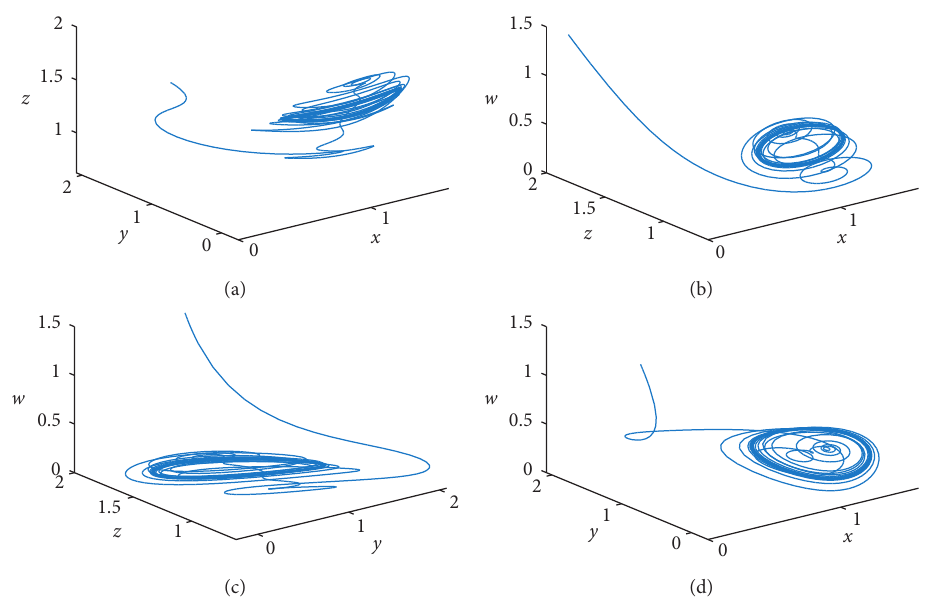
Figure 1: Three-dimensional spatial chaotic attractor phase diagram of system (1).